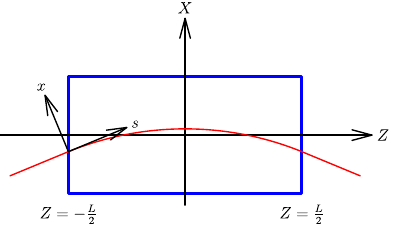
FIG. 1. Coordinates in a straight geometry combined-function dipole